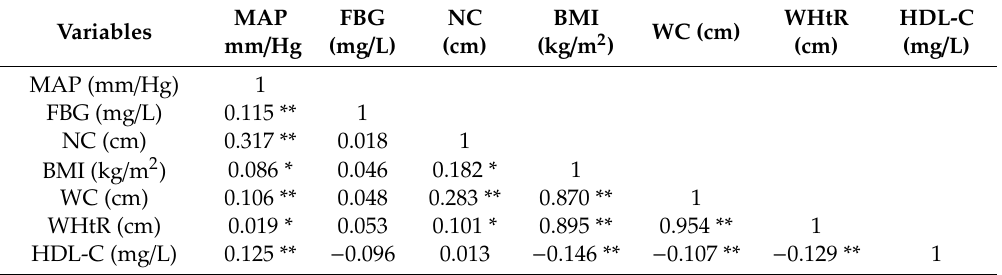
Table 2. Pearson correlation coe ffi cients for the association of obesity indices and components of MetS. Variables